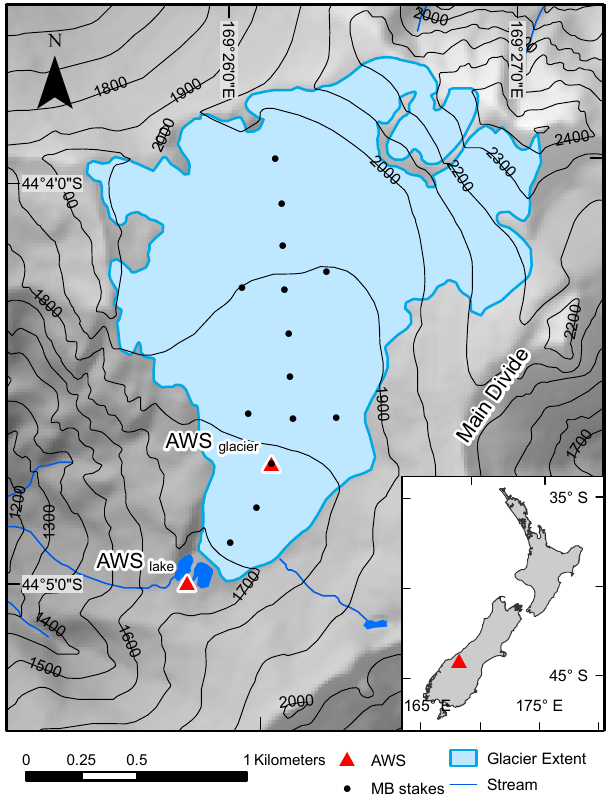
Figure 1. Map of Brewster Glacier showing AWS locations and surrounding topography. Contour lines are at 100m intervals. Long- term mass-balance network (MB stakes) shown as filled circles. The glacier margin shown is based on a 1997 GPS survey (Willis et al., 2009). The ridgeline to the southeast of the glacier is the main divide of the Southern Alps. The inset map shows the location of Brewster Glacier within New